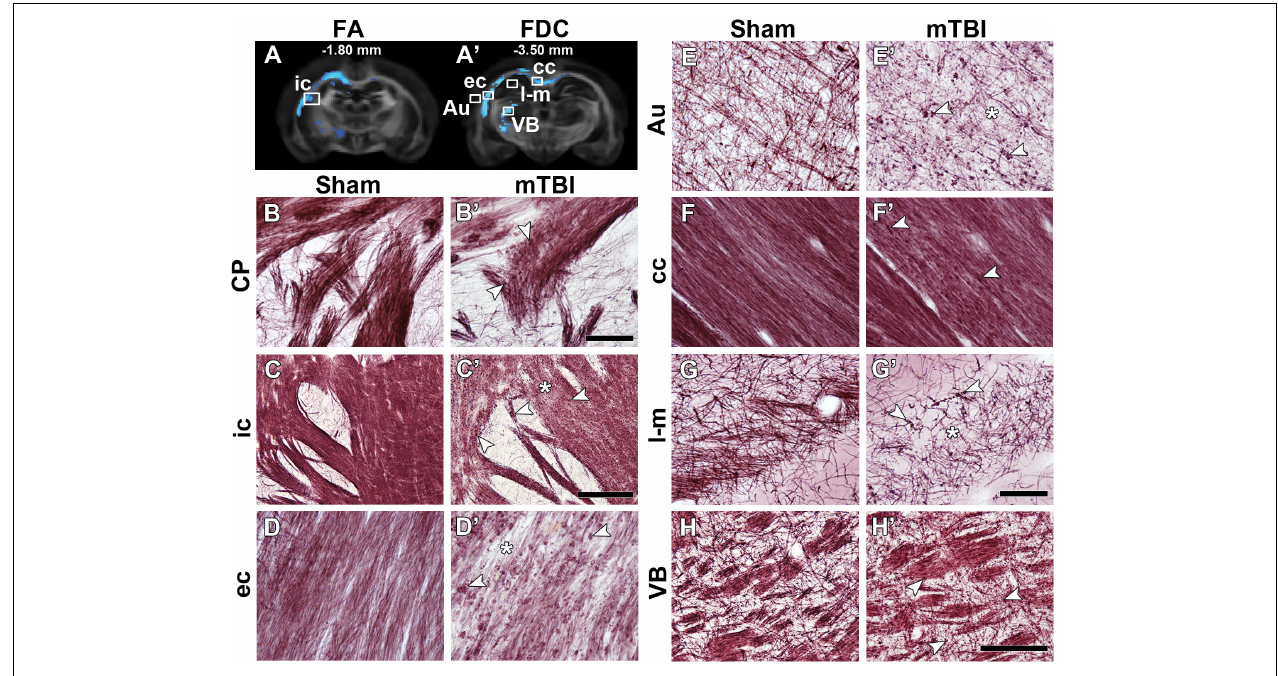
FIGURE 2 | FA (A) and FDC (A’) at –1.80 and –3.50 mm from bregma, respectively, from the group analyses. White squares indicate the location of the photomicrographs shown in (B–H) . Representative photomicrographs of myelin-stained sections of a sham-operated and a mTBI rat from the caudate putamen (B,B’) from –0.90 mm (not shown in A ), internal capsule (C,C’) from –1.80 mm, and external capsule (D,D’) , auditory cortex (E,E’) , corpus callosum (F,F’) , stratum-lacunosum moleculare (G,G’) , and ventrobasal complex (H,H’) from –3.50 mm from bregma. White arrowheads point at myelin alterations associated with axonal damage and asterisks indicate areas with extensive decrease in density of myelinated axons. AI values of these two animals shown in this figure are shown in Supplementary Table 1 . Au, auditory cortex; cc, corpus callosum; CP, caudate putamen; ec, external capsule; ic, internal capsule; l-m, stratum-lacunosum moleculare; VB, ventrobasal complex. Scale bars: 50 µ m (B,B’,D,D’–G,G’) , 150 µ m (H,H’) , and 250 µ m (C,C’)